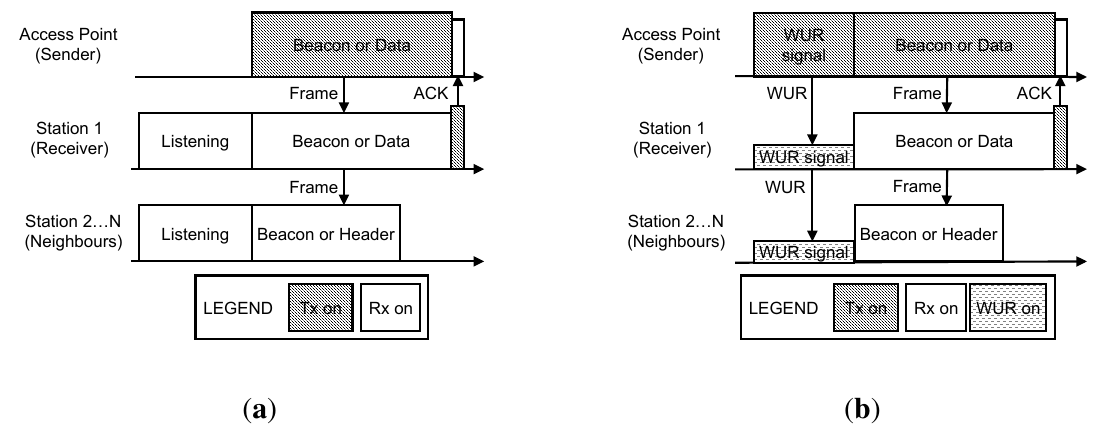
Figure 5. Comparison of the proposed MAC protocol with a conventional MAC protocol. ( a ) Conventional MAC protocol; ( b ) proposed MAC